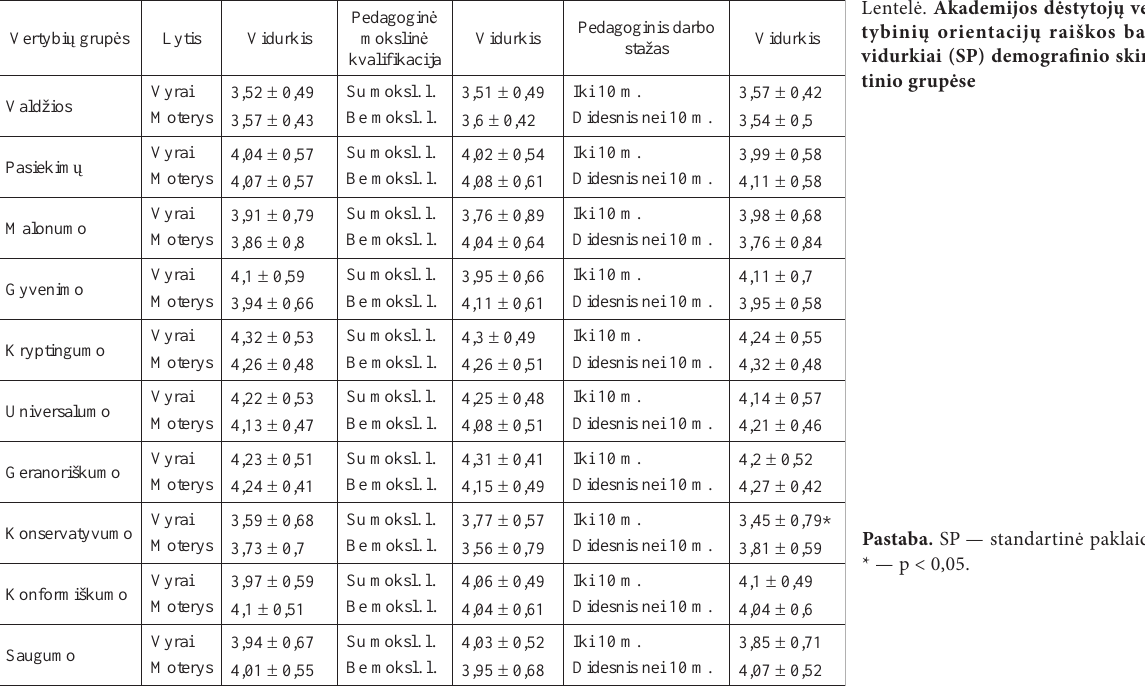
Pastaba. SP — standartinė paklaida. * — p <